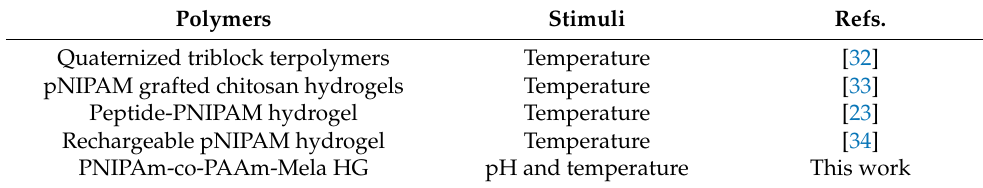
Table 3. Various PNIPAM-based copolymer hydrogels for Cur delivery. Polymers Stimuli Refs.